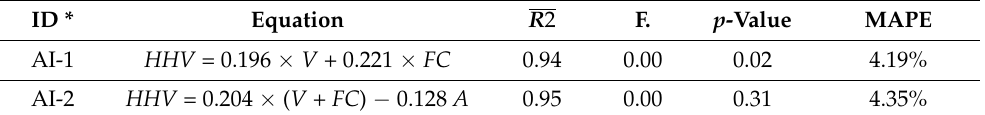
Table 6. Summary of the obtained HHV equations from proximate analysis, AI-1 and AI-2. ID *